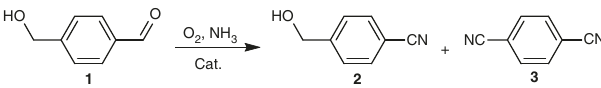
Fig. 4 Aerobic ammoxidation of 4-hydroxymethylbenzaldehyde. The ammoxidation of 1 can occur selectively on the aldehyde group to give hydroxynitrile product of 2 , or can occur nonselectively to give dinitrile product of